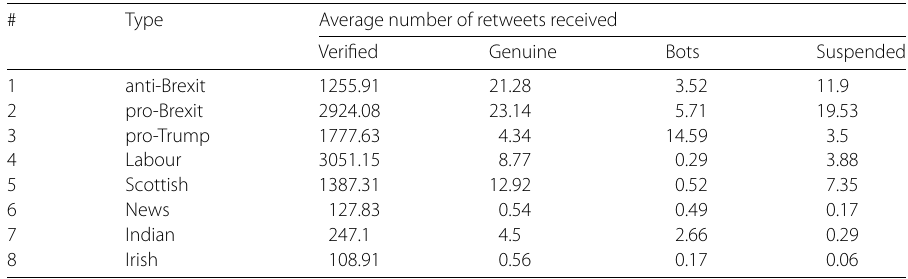
Table 3 Average total number of retweets received by users of discursive communities of Fig. 5. In some communities, bots or suspended users are able to make themselves more credible and be retweeted much more: the bots of the pro-Trump community, for instance, are retweeted much more than in the other communities, while the suspended users of pro- and anti-Brexit communities get more attention than the